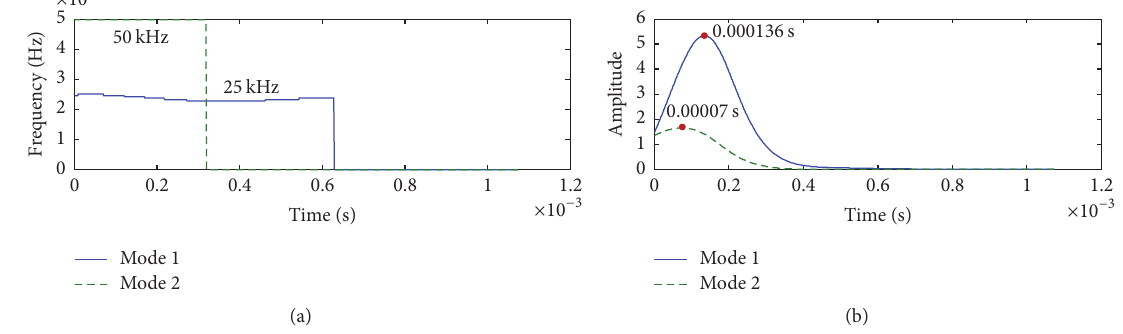
Figure 16: The final IFs and IAs of no defect by using the presented algorithm: (a) IF and (b)